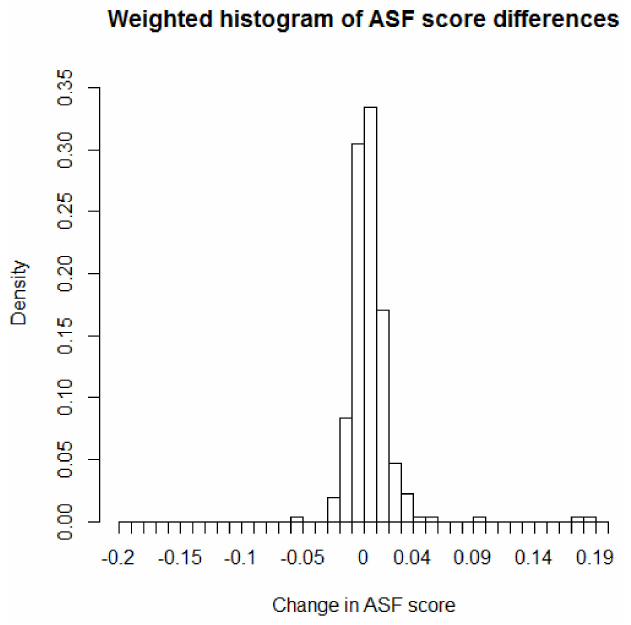
Figure 2. Plot showing inverse cluster size weighted histogram of ASF score differences.